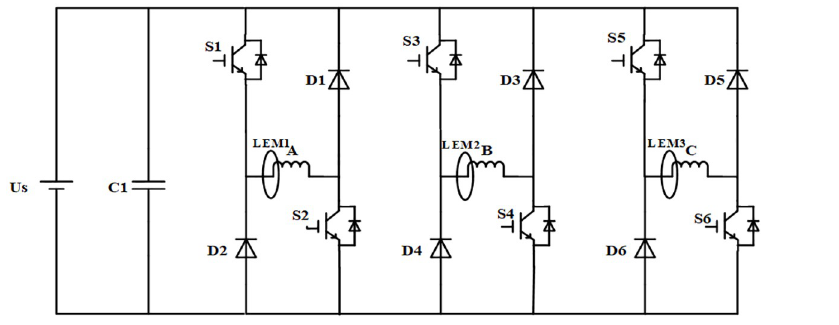
Fig 1. Topology of SRM power converter.